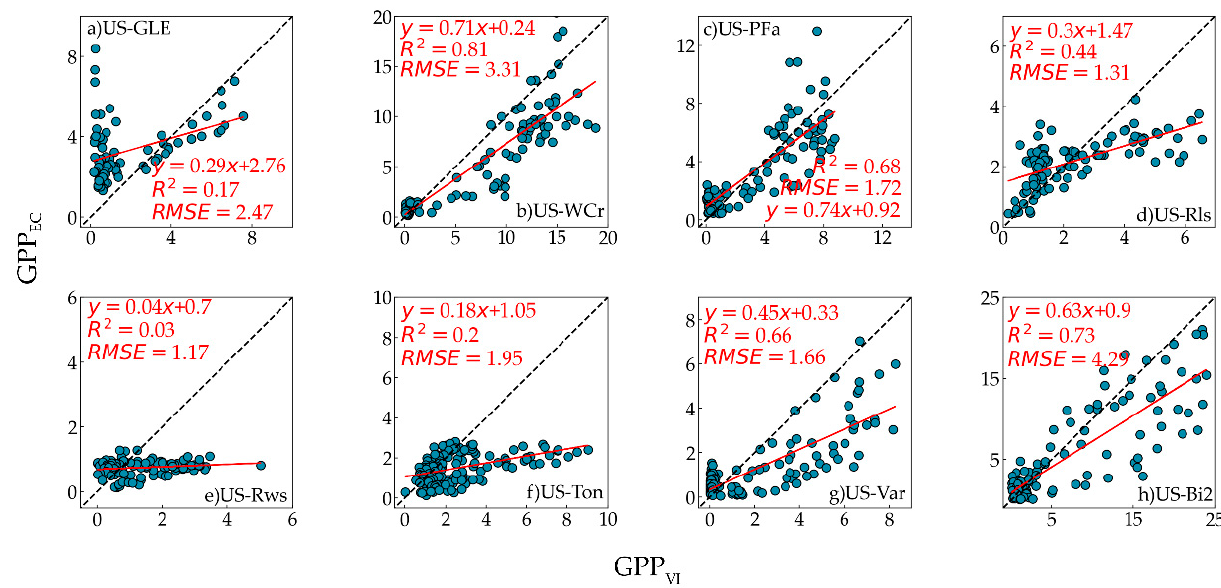
Figure 6. Scatter plots between GPP VI and GPP EC for all sites in 2017–2018. ( a – h ) represent the site the same as Figure 4. The time series of GPP GR , GPP VI and GPP EC in 2017–2018 are presented in Figure 7.